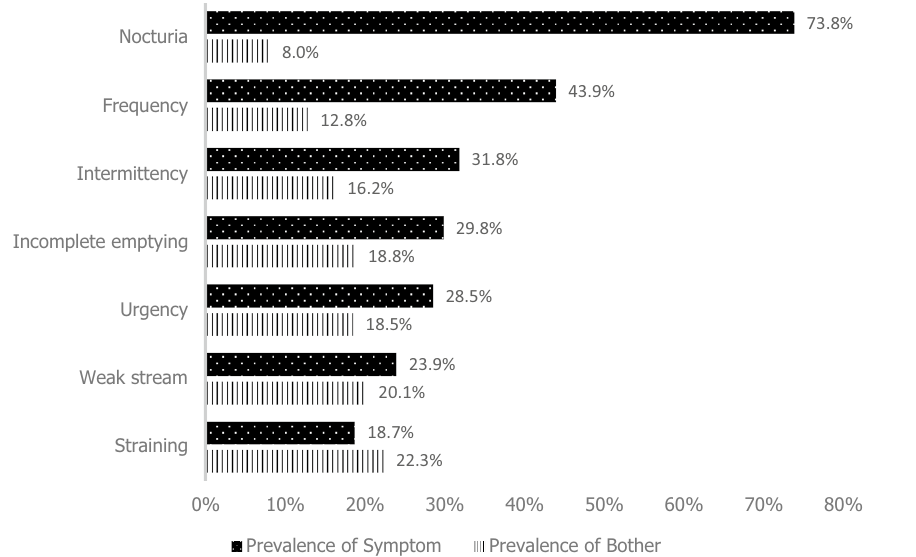
Figure 1. Prevalence of lower urinary tract symptoms (LUTS) and bother.